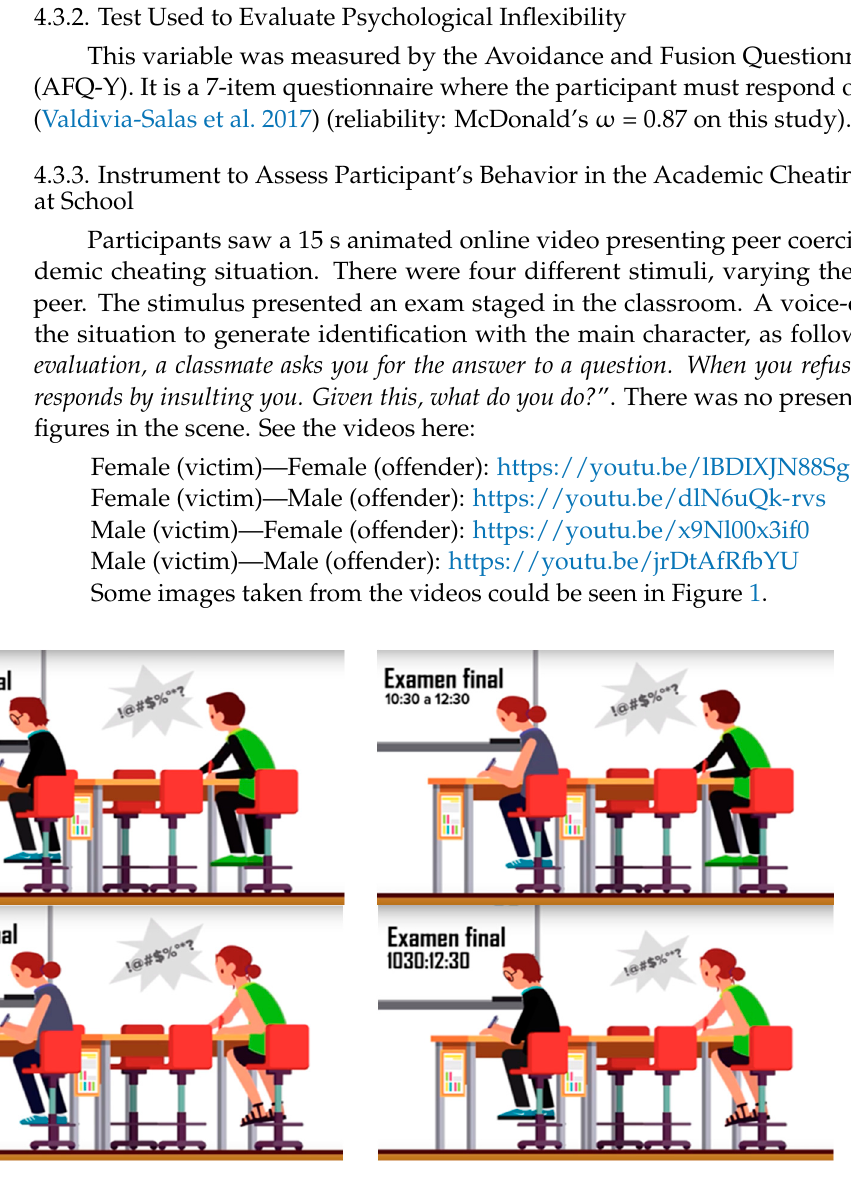
Figure 1. Stimulus simulating academic cheating coercion at school. In each box, the offender’s character is on the right and the participant’s character on the left.